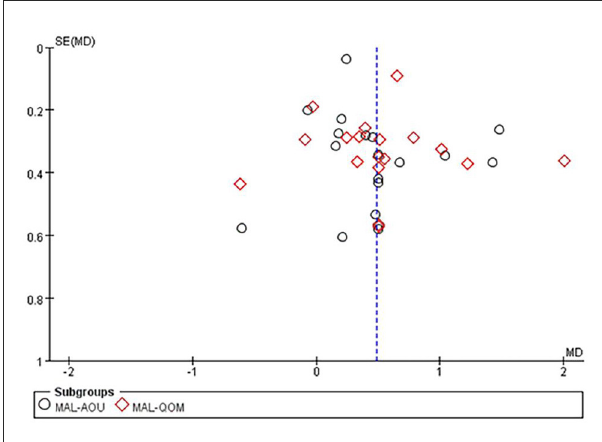
FIGURE4 The funnel plot of MAL comparing CIMT plus CR and CR.